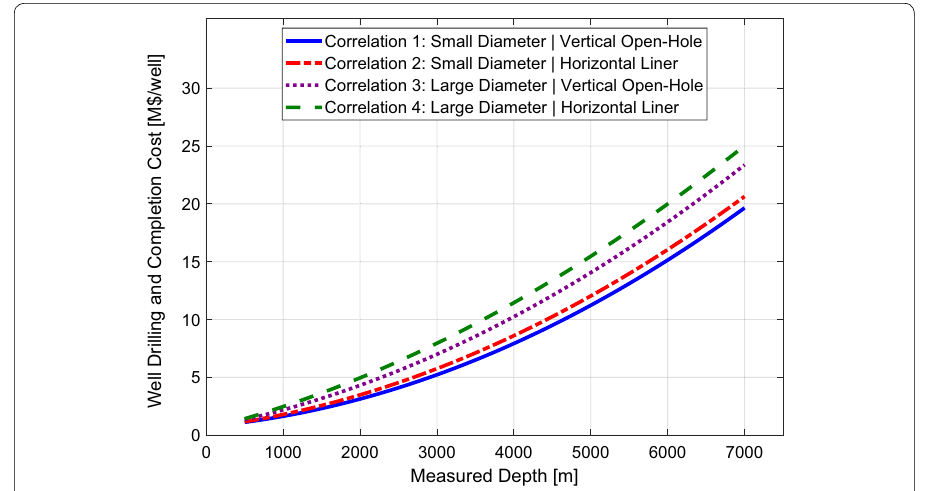
Fig. 3 GEOPHIRES built-in well drilling and completion cost correlations for four different well types (Lowry et al. 2017). Small and large diameter refers to 8½-in. and 12¼-in. bottom-hole diameter. Plotted cost